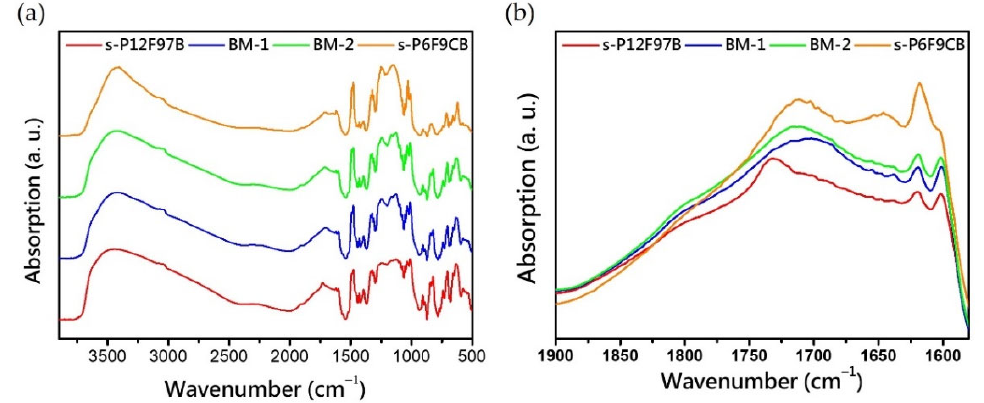
Figure 2. ( a ) ATR ‐ FTIR spectra of modified membranes and ( b ) partial spectral overlap between